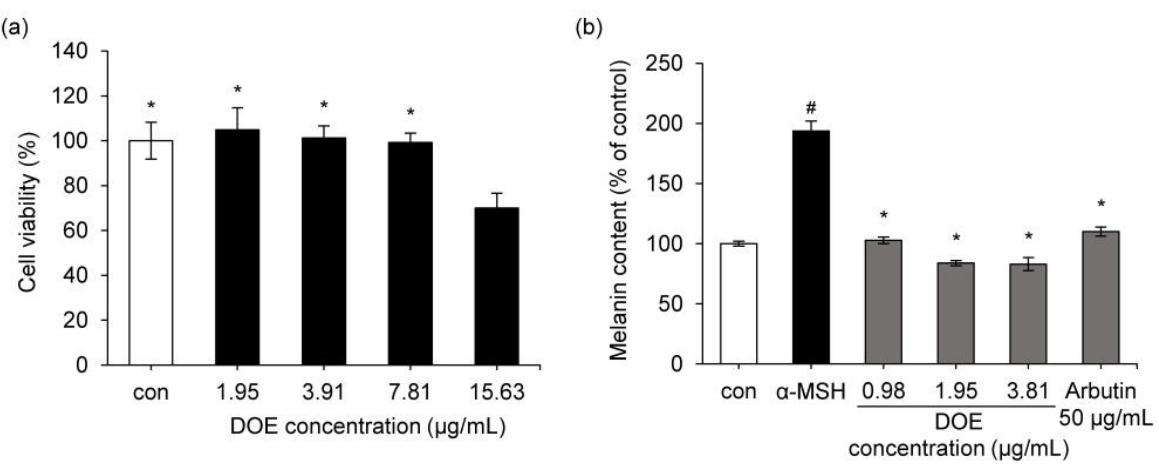
Figure 3. ( a ) Effect of DOE on the viability of B16F10 cells. * p < 0.05 vs. DOE 15.63 µ g/mL treated group. ( b ) Effect of DOE on α -MSH-induced melanin biosynthesis in B16F10 cells. * p < 0.05 vs. α -MSH-treated group. # p < 0.05 vs. control group. Positive control = 50 µ g/mL arbutin. Data are presented as mean ± SD.